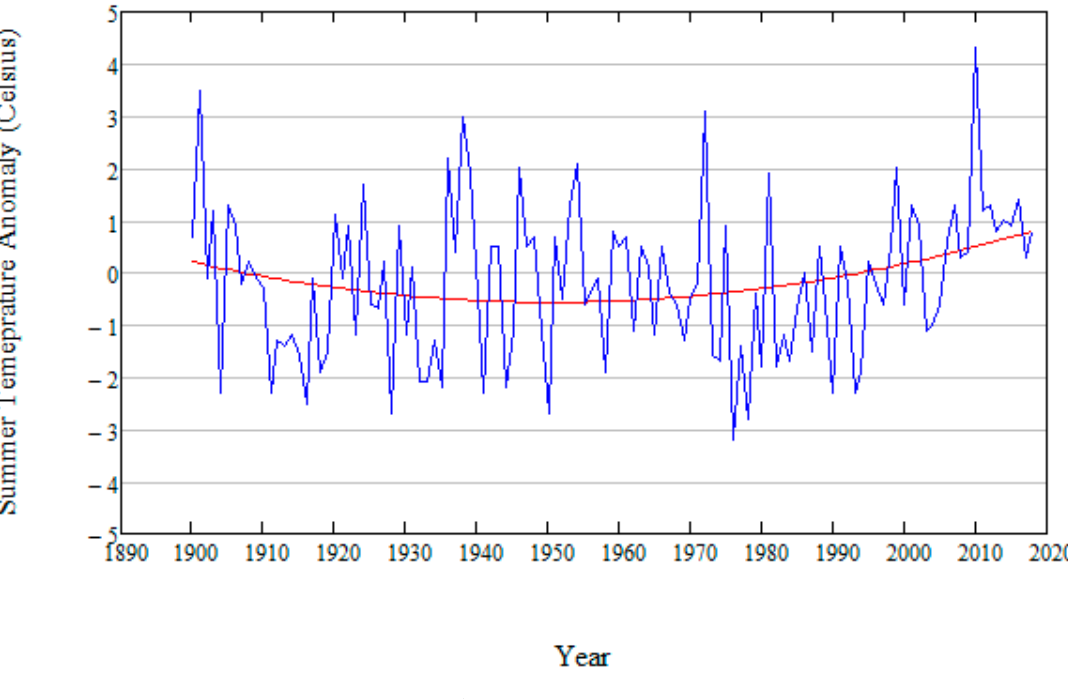
Figure 2. Mean temperature anomalies ( ◦ C) during the summer season in the Belgorod Region. A quadratic fit line is shown in red ( ◦ C).